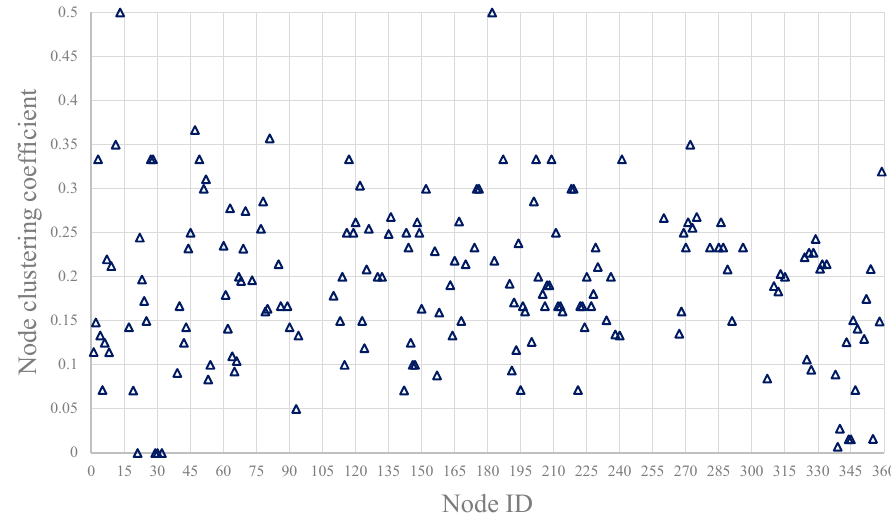
Figure 6. Clustering coefficient of the nodes in the ENRRTP.